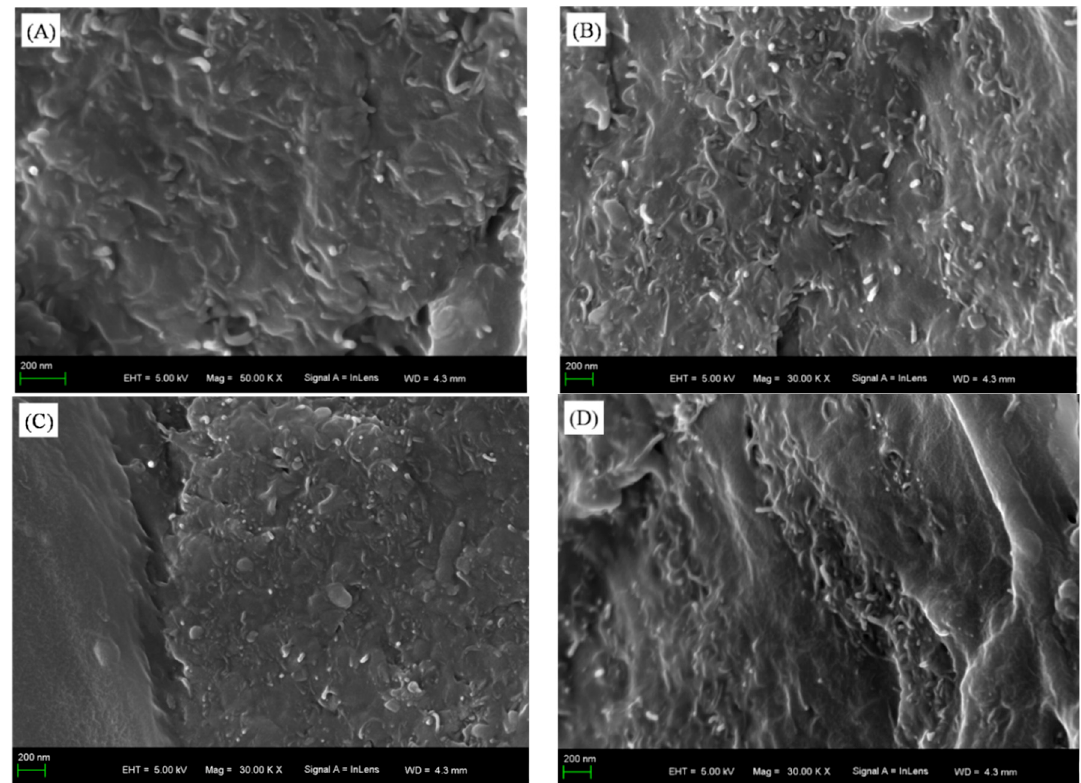
Figure 1. Cross-sectional morphologies of waterborne polyurethane (WPU) coatings with different multi-walled carbon nanotube (MWCNT) contents: ( A ) coating prepared by electrostatic spraying (ESC) with 0.3 wt% MWCNT, ( B ) ESC with 0.6 wt% MWCNT, ( C ) coating prepared by brushing (BrC) with 0.3 wt% MWCNT, and ( D ) BrC with 0.6 wt% MWCNT.